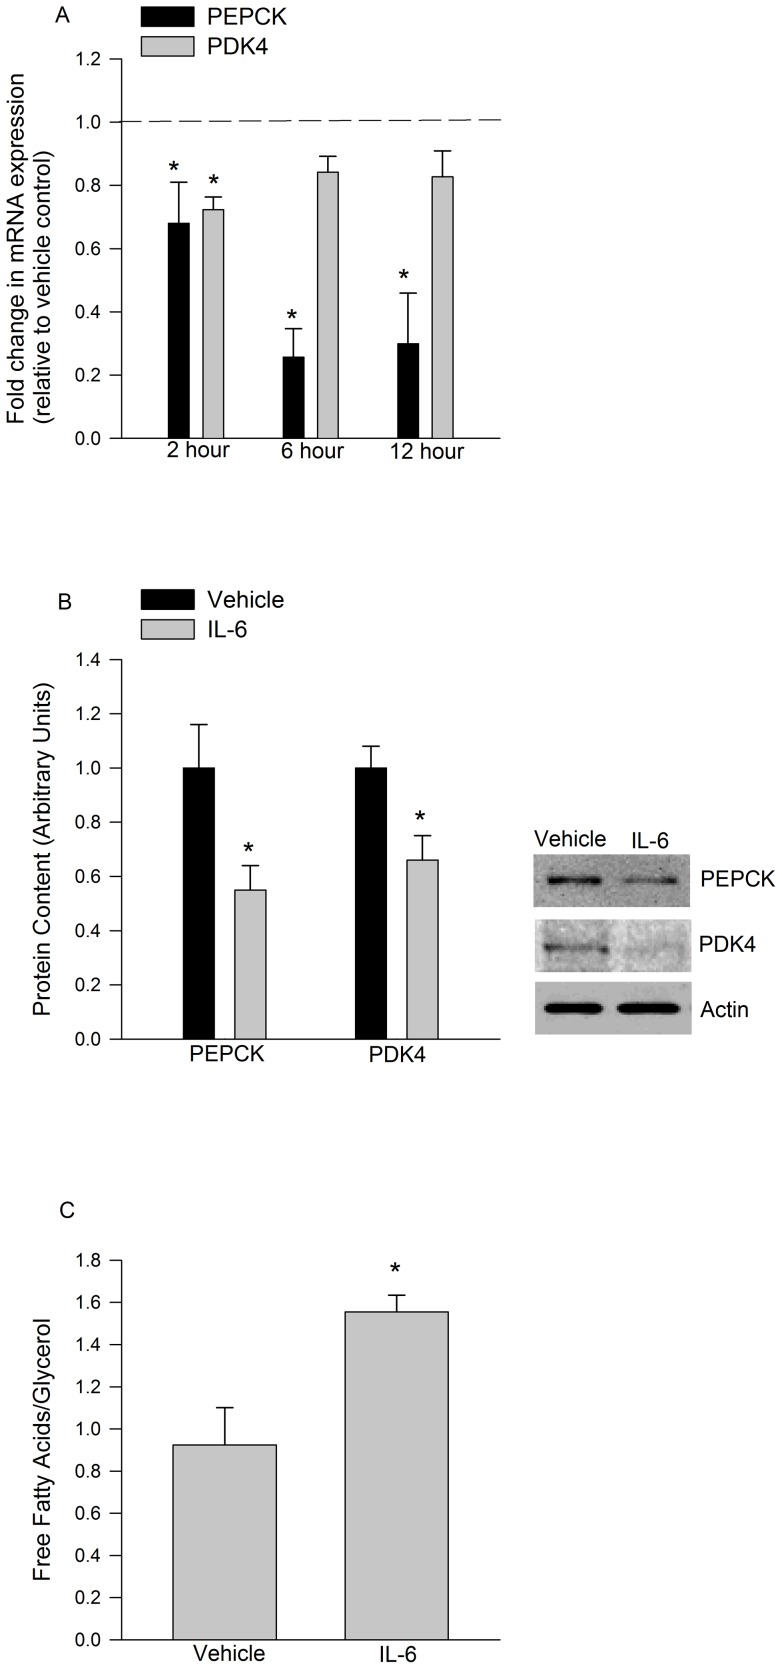
The effects of IL-6 on PEPCK and PDK4.
Ex vivo IL-6 treatment (150 ng/ml) decreases A) PEPCK and PDK4 mRNA expression and B) protein content in cultured eWAT (150 ng/ml, 12h). These changes are associated with increases C) in free fatty acids to glycerol ratio following long-term (150 ng/ml, 24 hours) IL-6 treatment. Data are presented as means + SE for 7 cultures per group. The mRNA data are normalized to beta actin mRNA and expressed as fold differences compared to vehicle controls in A. Representative Western blot images are given to the right of the quantified data in B. * P<0.05 versus vehicle control.